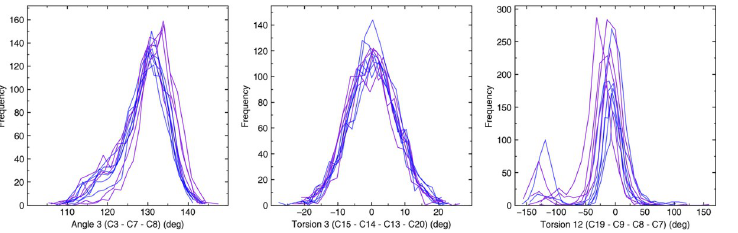
Fig 4. Frequency distribution of Angle 3, Torsion 3 and Torsion 12 observed in each opsin simulation. Blue and violet colors correspond to Sws2 photopigments with λ max values > 430 nm vs. λ max values < 430 nm, respectively.